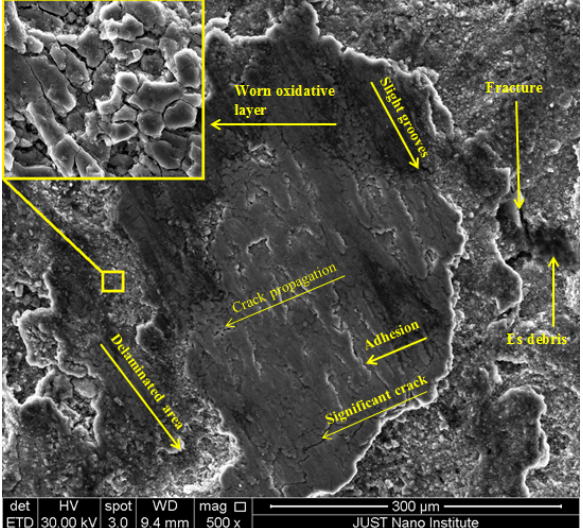
Figure 14: SEM micrograph of worn out surfaces of Al-1.5Mg-1.5Sn- 9Es composite showing slight grooves, delaminated area, sever crack propagation and worn oxidative layer discovered by